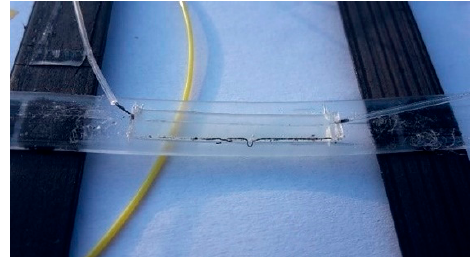
Figure 3. FBG sensor installed on the